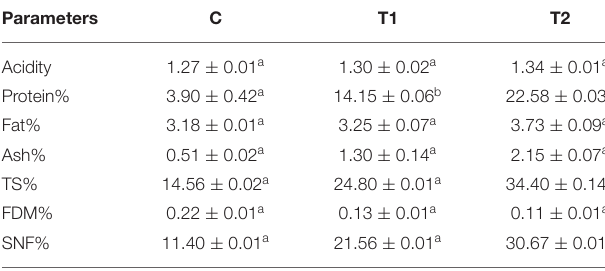
TABLE 1 | Chemical composition of probiotic WPI-enriched concentrated yogurt.